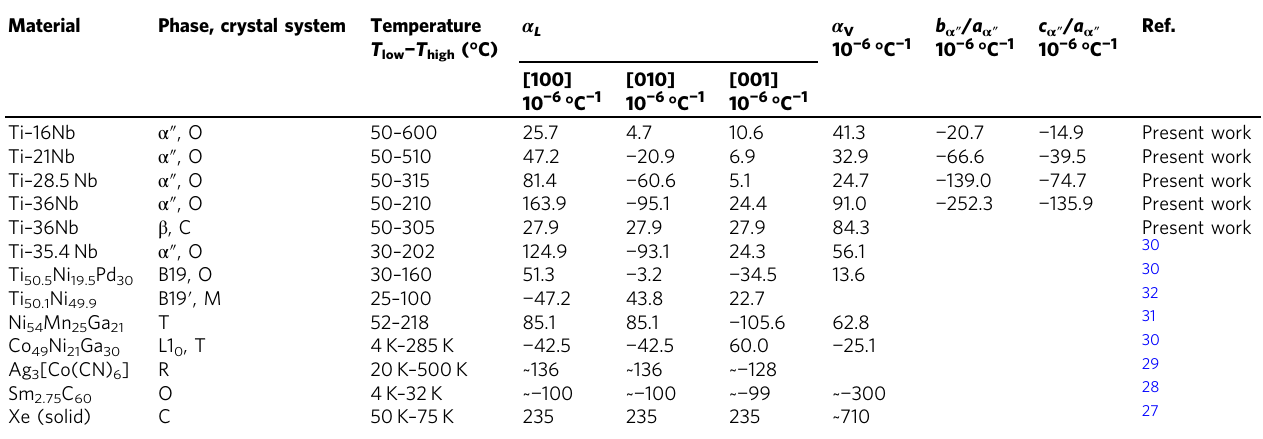
Table 1 Thermal expansion rates of martensitic Ti – Nb alloys compared with the literature Material Phase, crystal system Temperature